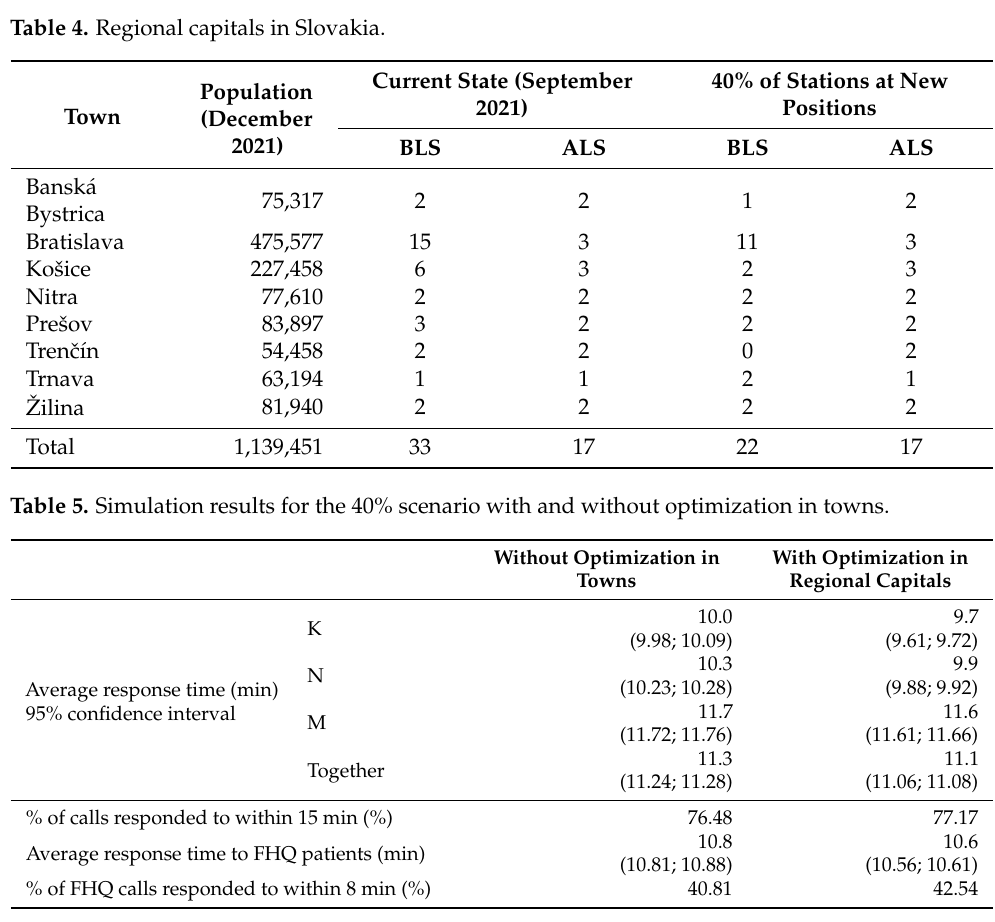
Table 4. Regional capitals in Slovakia.